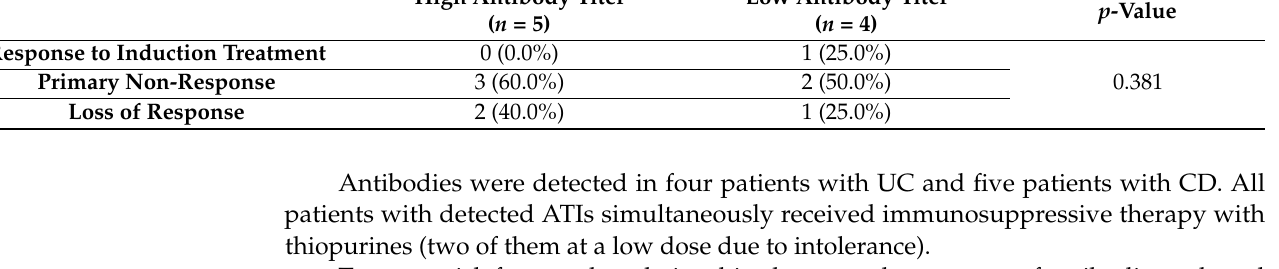
Table 3. Relationship between response to treatment and antibody titers. High Antibody Titer